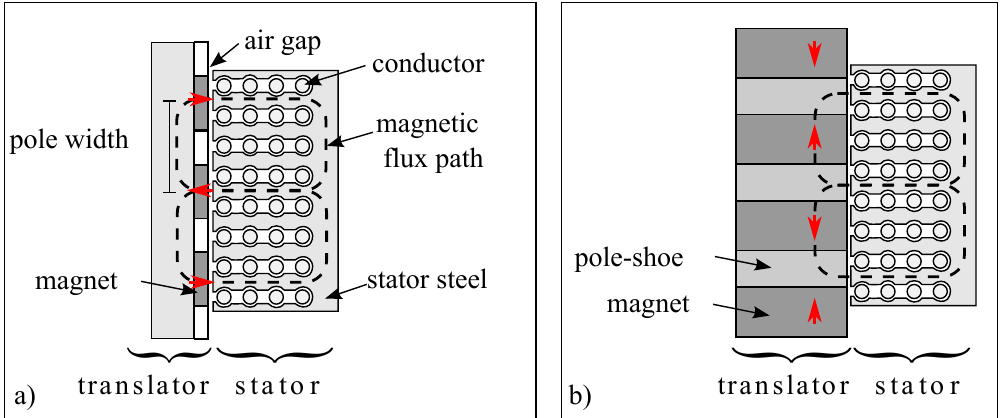
Figure 4. Schematics of the surface mounted translator design used for the L10 ( a ) and the sandwich mounted translator design used for the L12 ( b ). Red arrows show the direction of the magnetization of the permanent magnets. The dashed lines show some of the magnetic flux paths, and it could be noted that they are similar in the stator for both